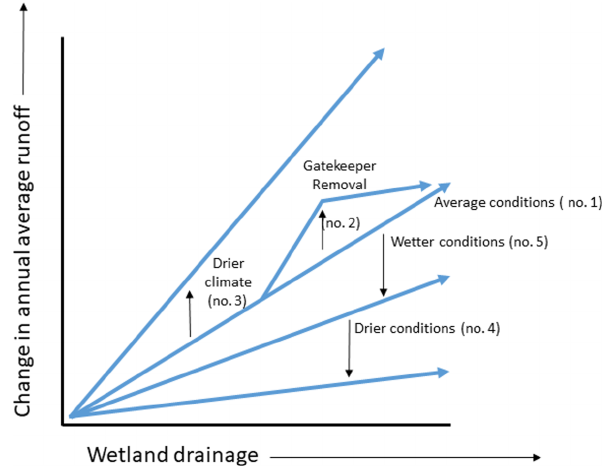
Figure 11. Conceptual framework of runoff response to wetland drainage in the Prairie Pothole Till class. Five different runoff re- sponses to drainage are shown, representing a range of annual wet- ness/dryness conditions and climate. Complete description of these responses is provided in the discussion